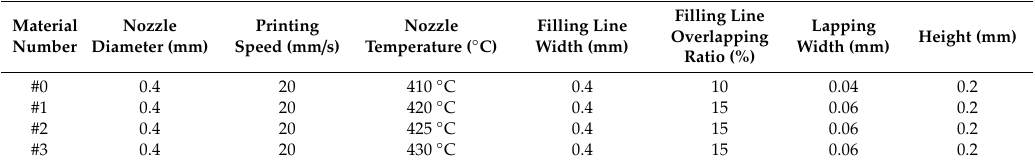
Table 3. FDM processing parameters of PEEK/tungsten composite materials.